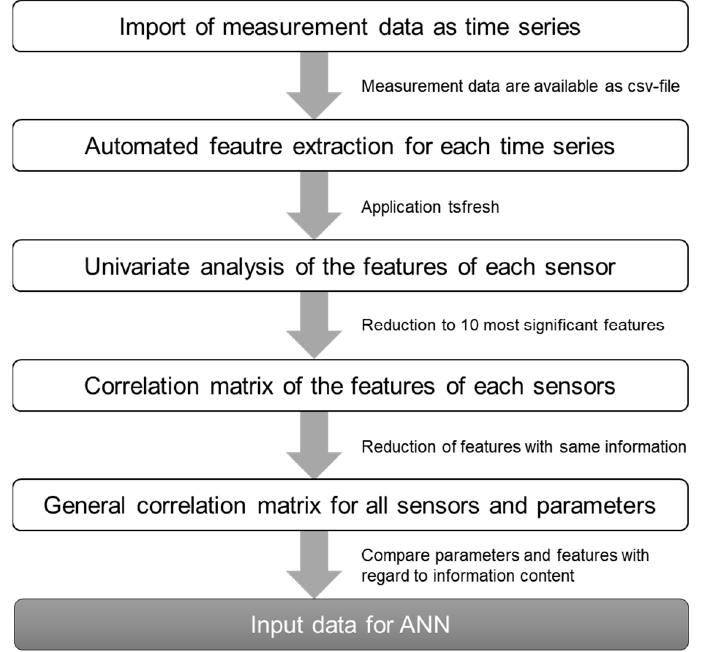
Figure 2. Procedure for data preparation.